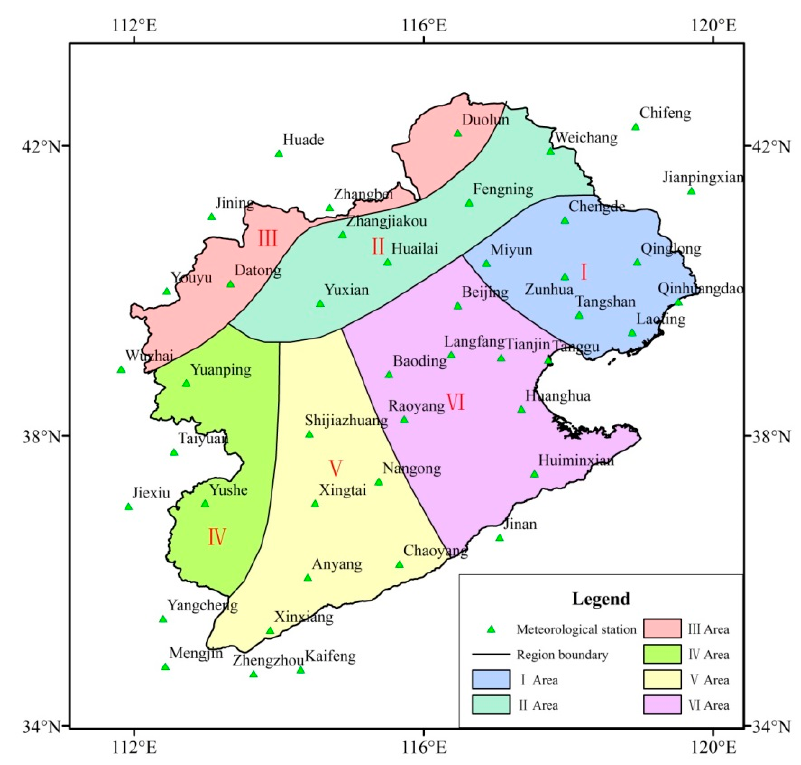
Figure 3. The sub-region categorization of the HRB.